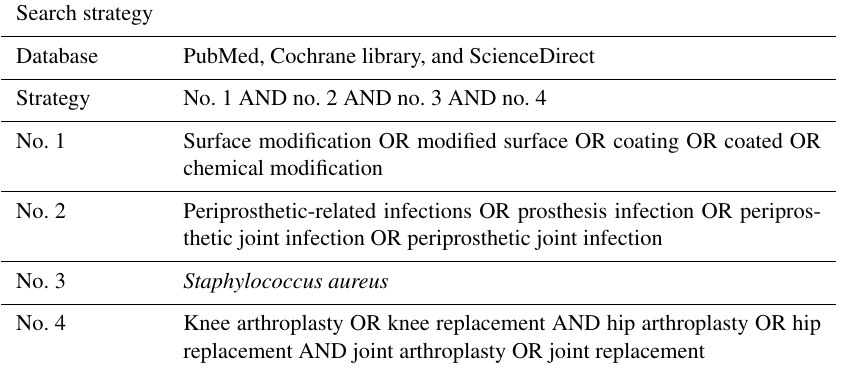
Table 1. Keywords for the search